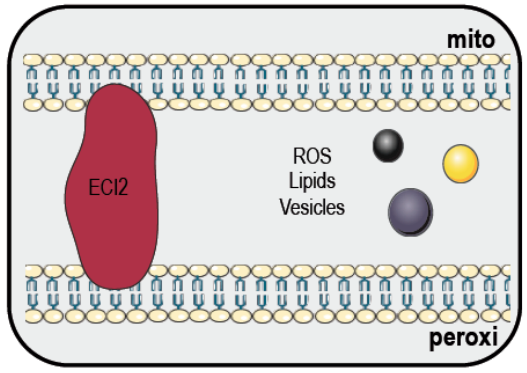
Figure 4. Mitochondria–peroxisome contact sites. At these contact sites, enoyl-CoA isomerase 2 (ECI2) is the only physical tethering complex identified to date. The two organelles are thought to communicate with each other also through vesicles, ROS and lipids. Indeed, peroxisomes are important for ROS clearance and β -oxidation of fatty acids. Please refer to the text for further details. This figure was created using images from Servier Medical Art (http: // smart.servier.com). Servier Medical Art